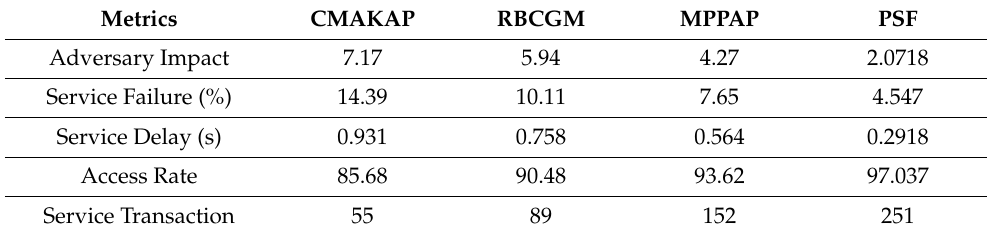
Table 5. Comparative analysis summary for access